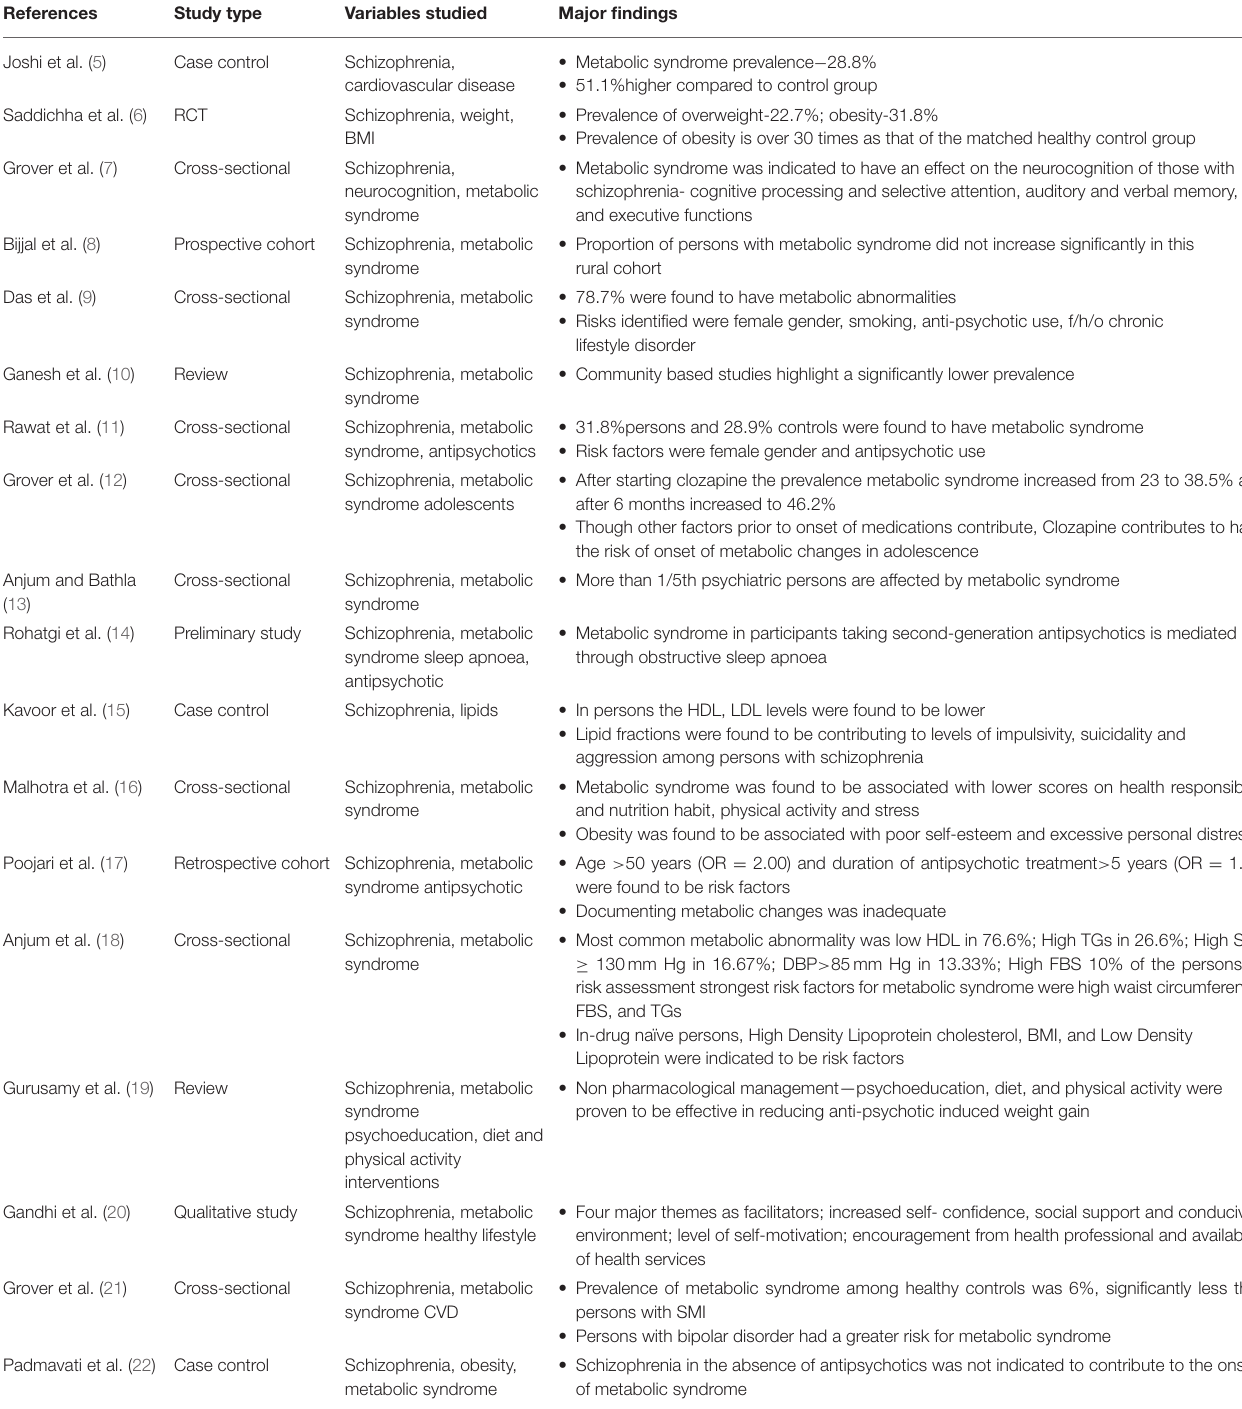
TABLE 1 | Studies on cardiovascular diseases among persons with schizophrenia from